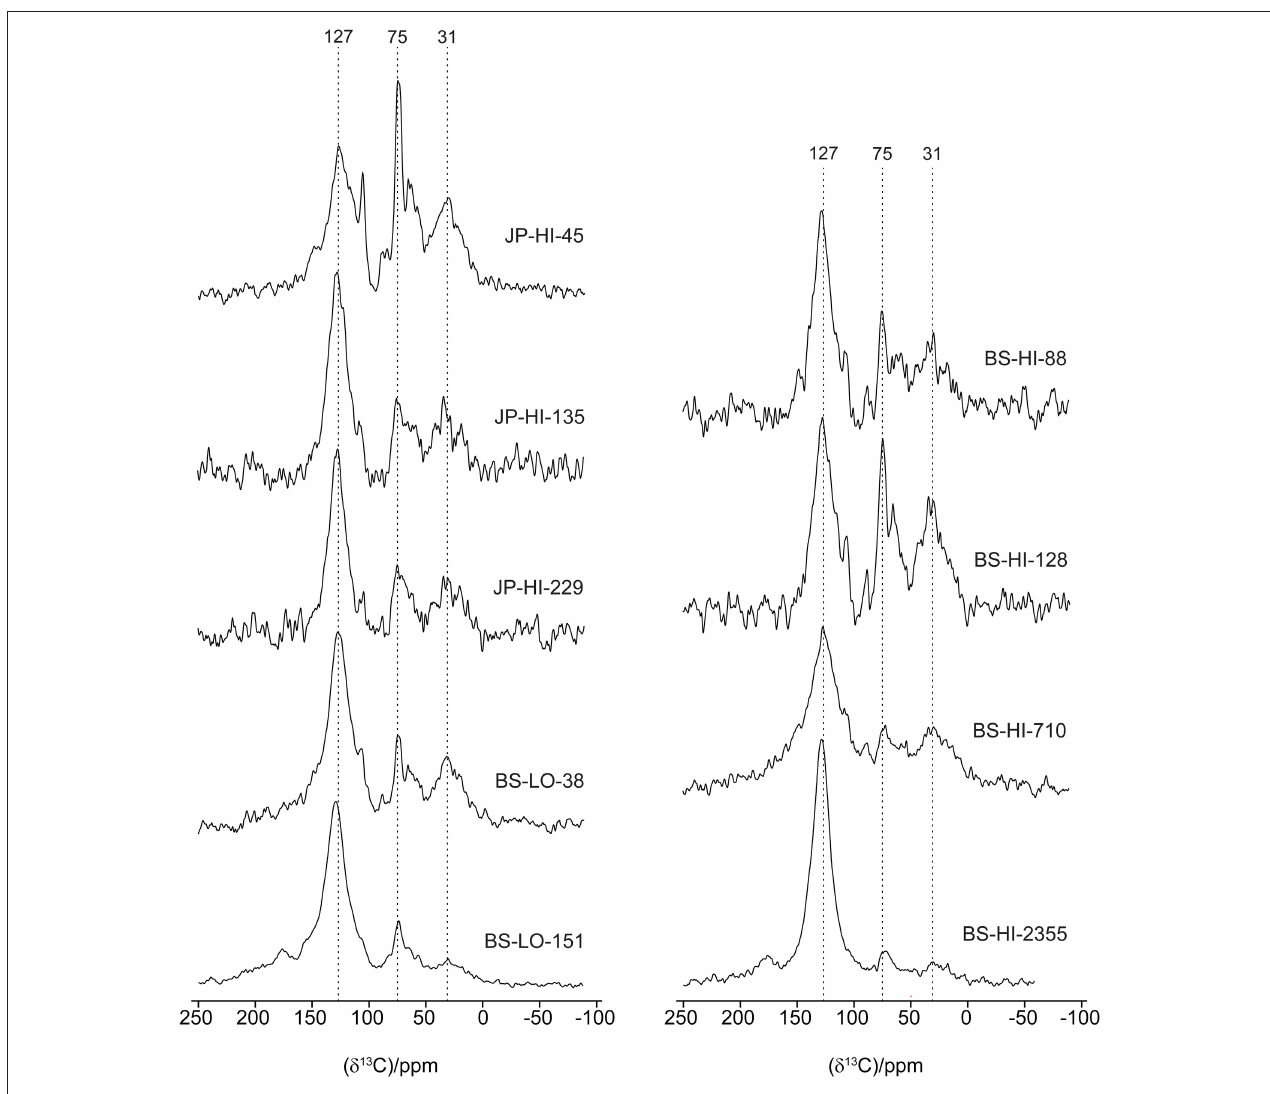
FIGURE 4 | Solid-state 13 C CPMAS NMR spectra of representative